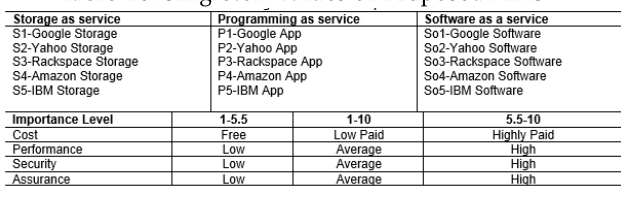
Table 10. Singleton Values of Proposed